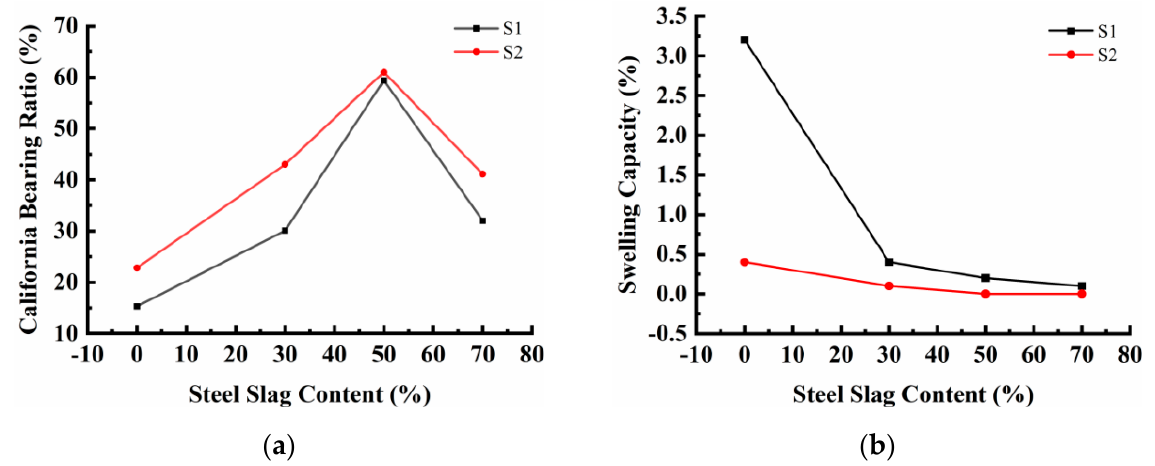
Figure 8. The CBR test results: ( a ) CBR values; ( b ) swelling capacity.